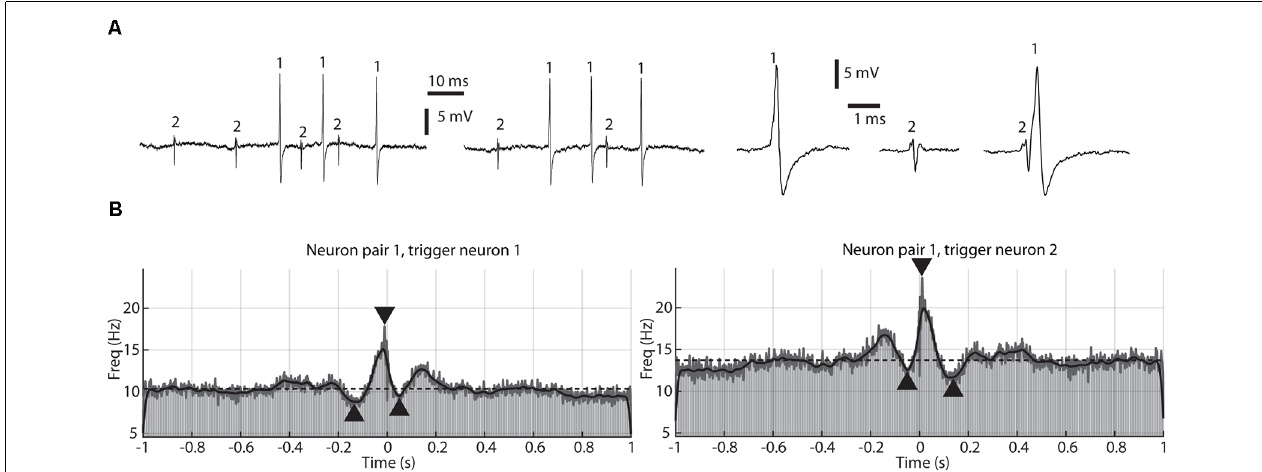
FIGURE 1 | A paired recording of two adjacent thalamic neurons and their correlation patterns. (A) Sample raw traces, one at the beginning of the recording session (left), one at the end of the session (middle), about 20 min later, and magnified traces of the individual spikes, as well as a sample of coinciding spikes (right). Occurrences of the two separate spikes, recorded through the same patch pipette, are indicated by numerals (1 and 2, respectively). These two neurons correspond to pair #1 in Figure 2 . (B) Correlation patterns between the two recorded neurons shown in (A) , one plot used neuron 1 as a trigger, and the other used neuron 2 as a trigger. The plots are peri-spike triggered histograms (PSpTH) with a bin width of 10 ms (light gray bars). Superimposed on the PSpTHs are Kernel Density Estimations of the spike-triggered activity (SpT-KDE). The gray line is an SpT-KDE with a short time constant (1 ms), and the black line an SpT-KDE with a longer time constant (10 ms). Horizontal dashed line indicates average baseline activity. Arrowheads indicate amplitudes and time points of the peak deflections, one for the pretrigger period, one for the peritrigger period, and one for the posttrigger